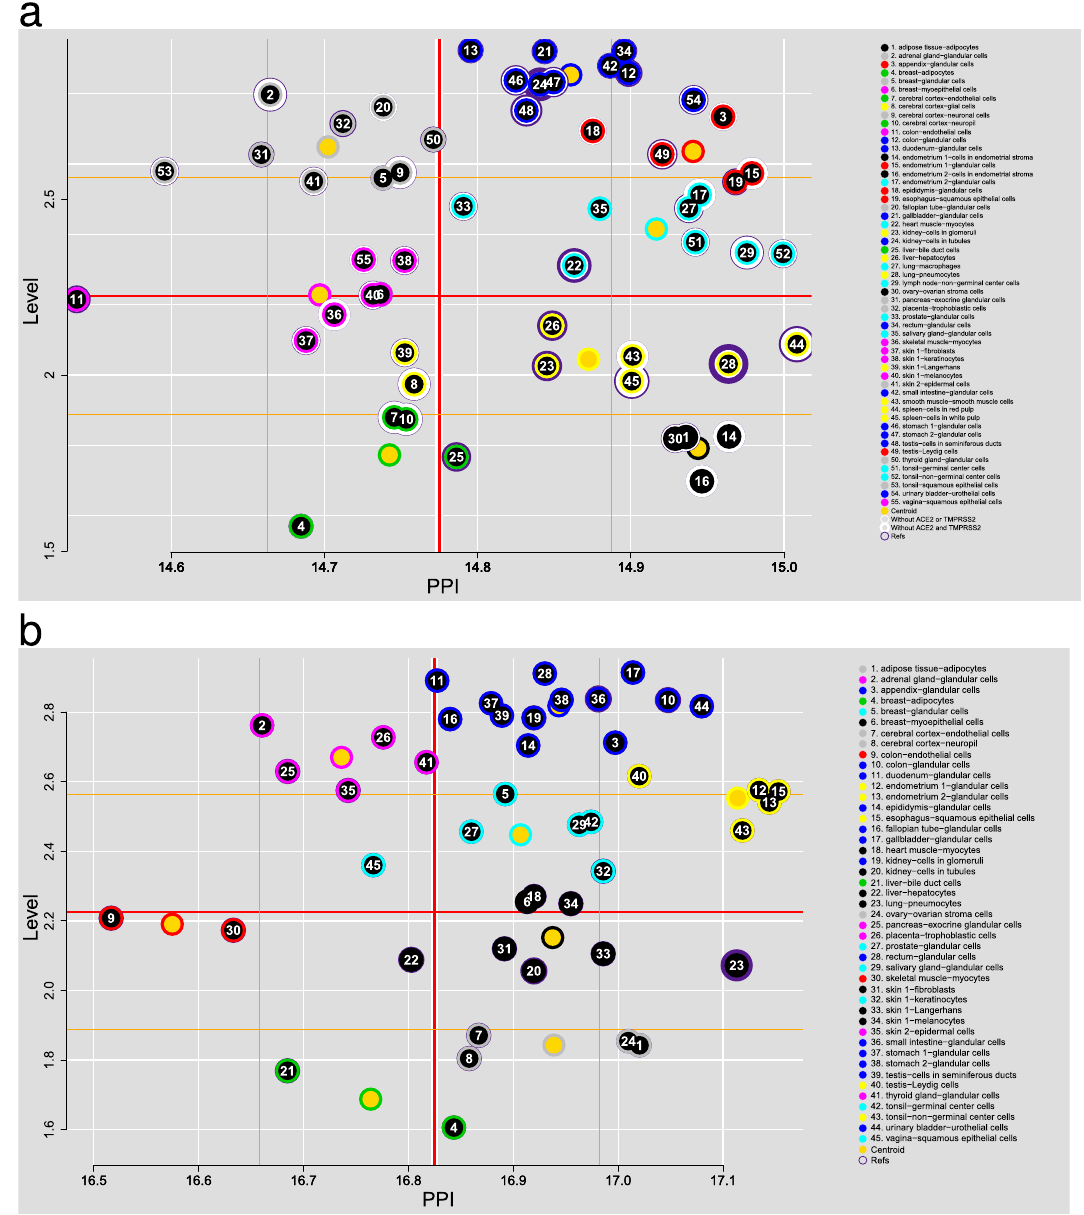
Figure 7. K-Means of the cells and their potential of infection. ( a ) SARS-CoV-2; at the top of quadrant 4, the cells most reported in the literature as infected in autopsies are identified (width purple ring), followed by quadrant 1. ( b ) SARS-CoV-1; pneumocytes are found in the same region as in ( a ) (upper side of quadrant 4, black group). Quadrant 1: high expression value (Level) and high PPI (upper right side); quadrant 2: high expression value and low PPI (upper left side); quadrant 3: low expression value and low PPI (bottom left); and quadrant 4: low expression value and high PPI (lower right side). As expected, glandular cells are mainly concentrated in the upper quadrants, gray, blue, red, and cyan cluster in ( a ) and lilac, blue, cyan, and yellow in ( b ). For Ref., see Supplementary Table S1, S2 and Supplementary